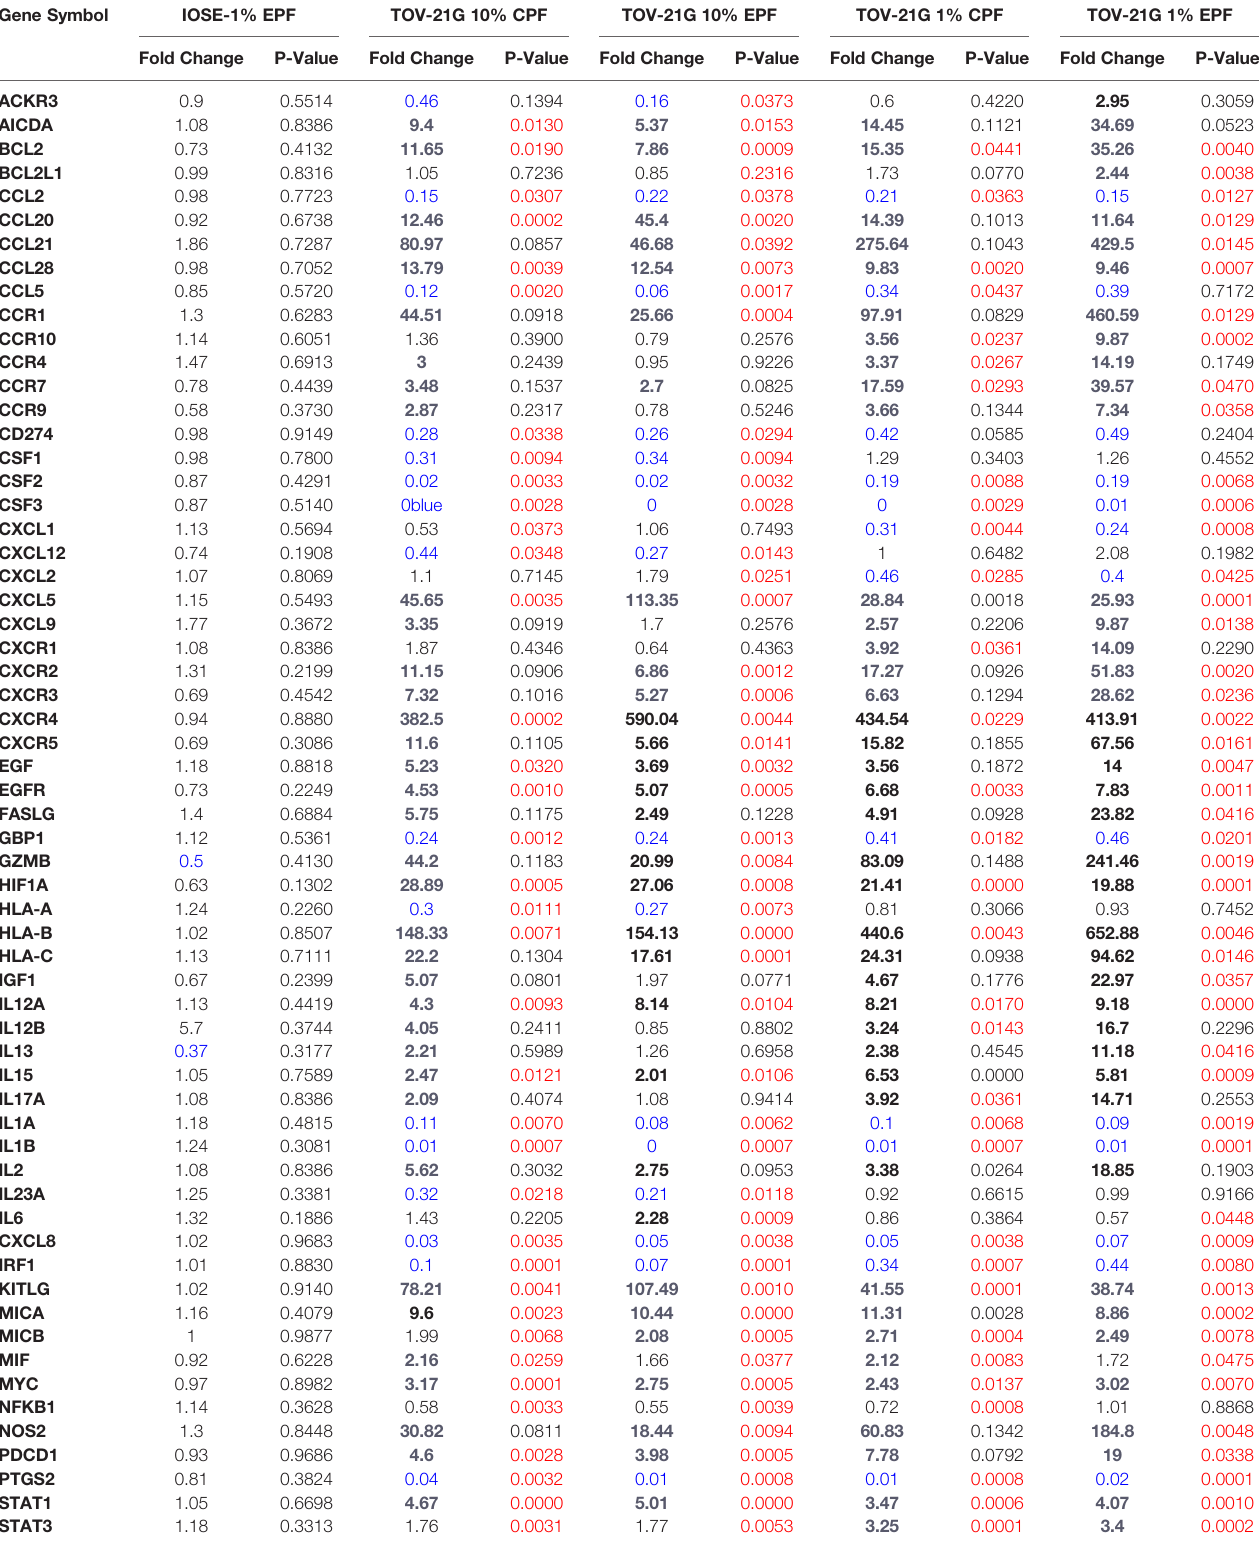
TABLE 1 | Signi fi cantly regulated cancer related genes in PF treated IOSE or TOV-21G cells. Gene